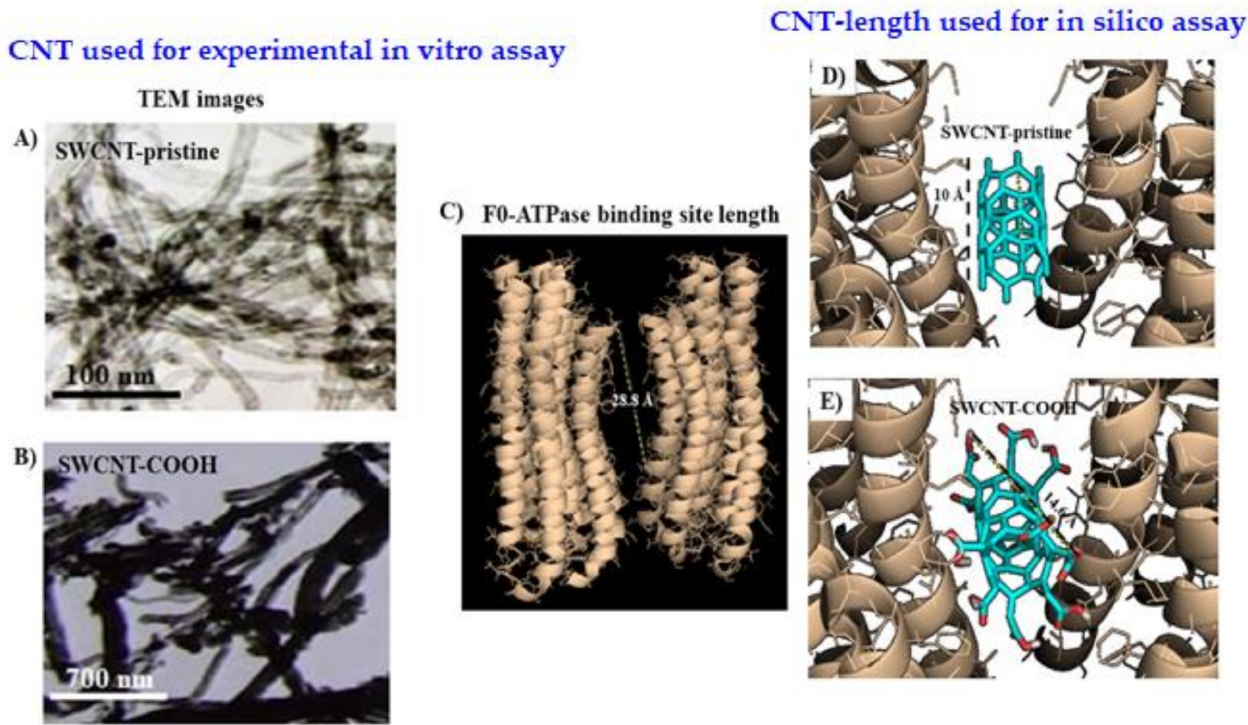
Figure 1. On the right, Transmission Electron Microscope (TEM) images obtained of carbon nanotubes, such as ( A ) SWCNT- pristine and ( B ) SWCNT-COOH used in this study for the experimental in vitro assay. On the left, ( C ) representation of the length of the unoccupied F0-ATPase binding site, ( D , E ) representation of the lengths of the theoretically modeled SWCNT-pristine and SWCNT-COOH within the F0-ATPase used for the in silico assay of F0-ATPase inhibition. Additional details can be found in the Supplementary Information in Figure